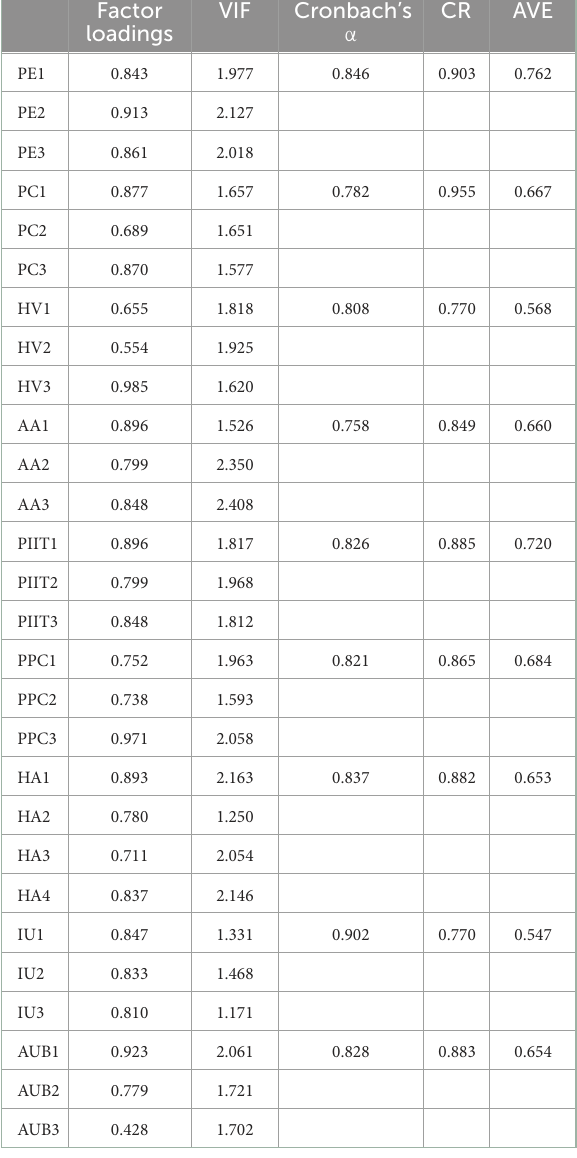
TABLE 3 Standardized factor loadings, VIFs, CRs and AVEs, Cronbach’s α in this